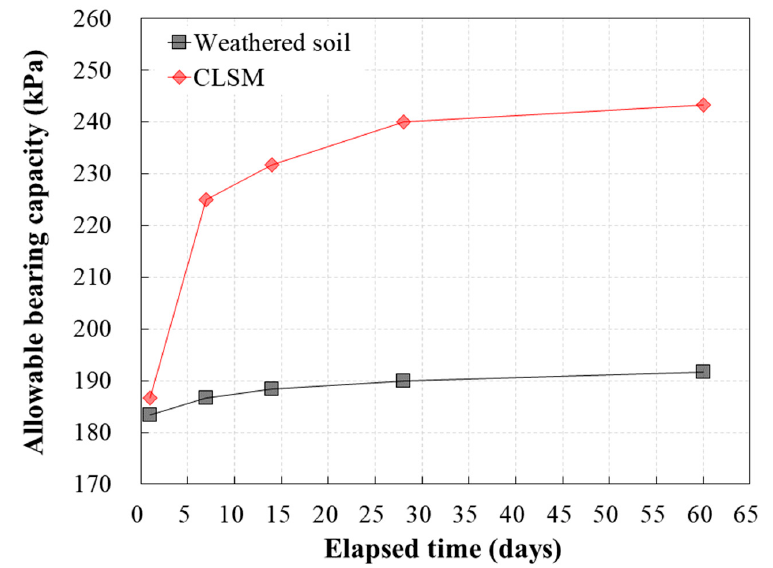
Figure 15. Comparison of allowable bearing capacity of weathered soil and CLSM.